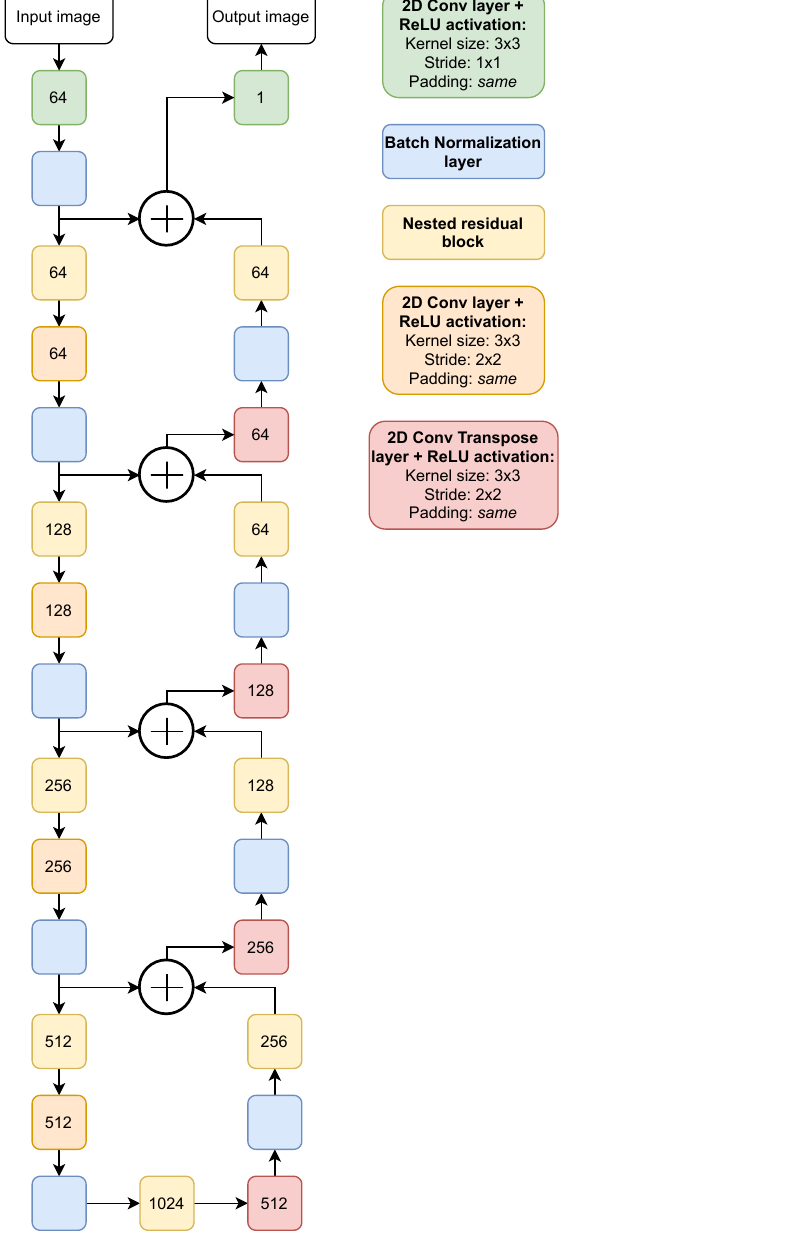
Figure 10. In-detail structure of the full architecture by Choi et al. [5]. The numbers inside some of the blocks represent the number of filters per layer. In the case of the nested residual blocks, the number corresponds to the number of filters in all of the convolution layers inside of its